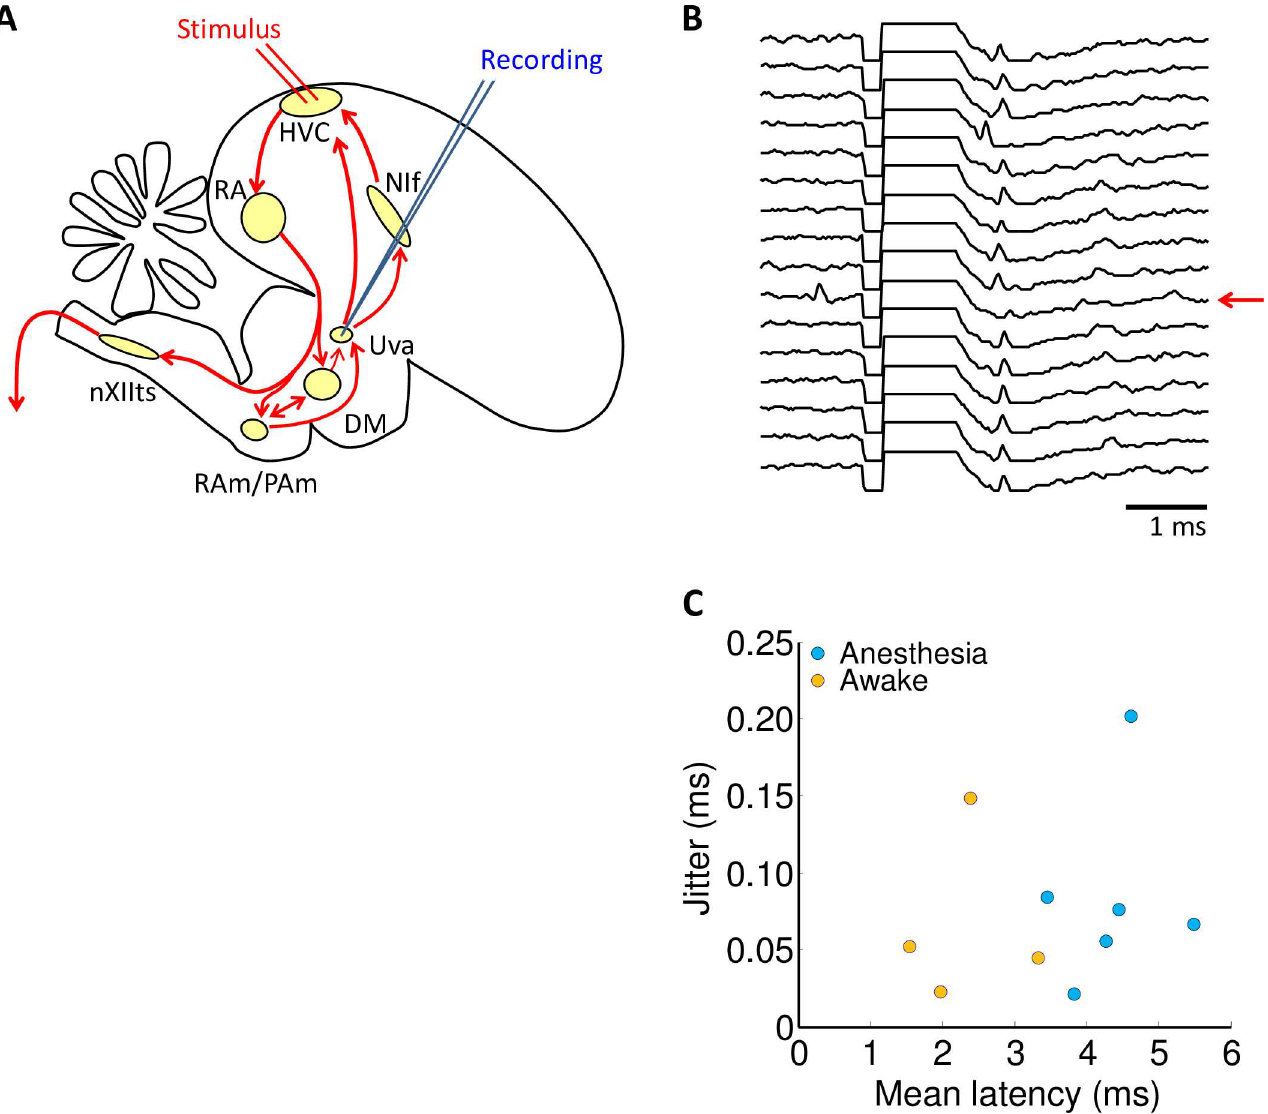
Fig 3. Multi-unit recordings in Uva during singing. (A) Simplifiedschematic view of the oscine song control system. Multiunit recordingswere made in HVC-projecting core of Uva, which was antidromicallyidentifiedby electricalstimulationin HVC. (B) Antidromic activationof neuronsin Uva. Traces shows the responsein Uva across sequential stimulations. Red arrow indicates a trial duringwhich a spontaneous spike occurred, preventing in antidromic responsein Uva. (C) Latency and jitter of antidromicresponsesin awake and anesthetized birds.